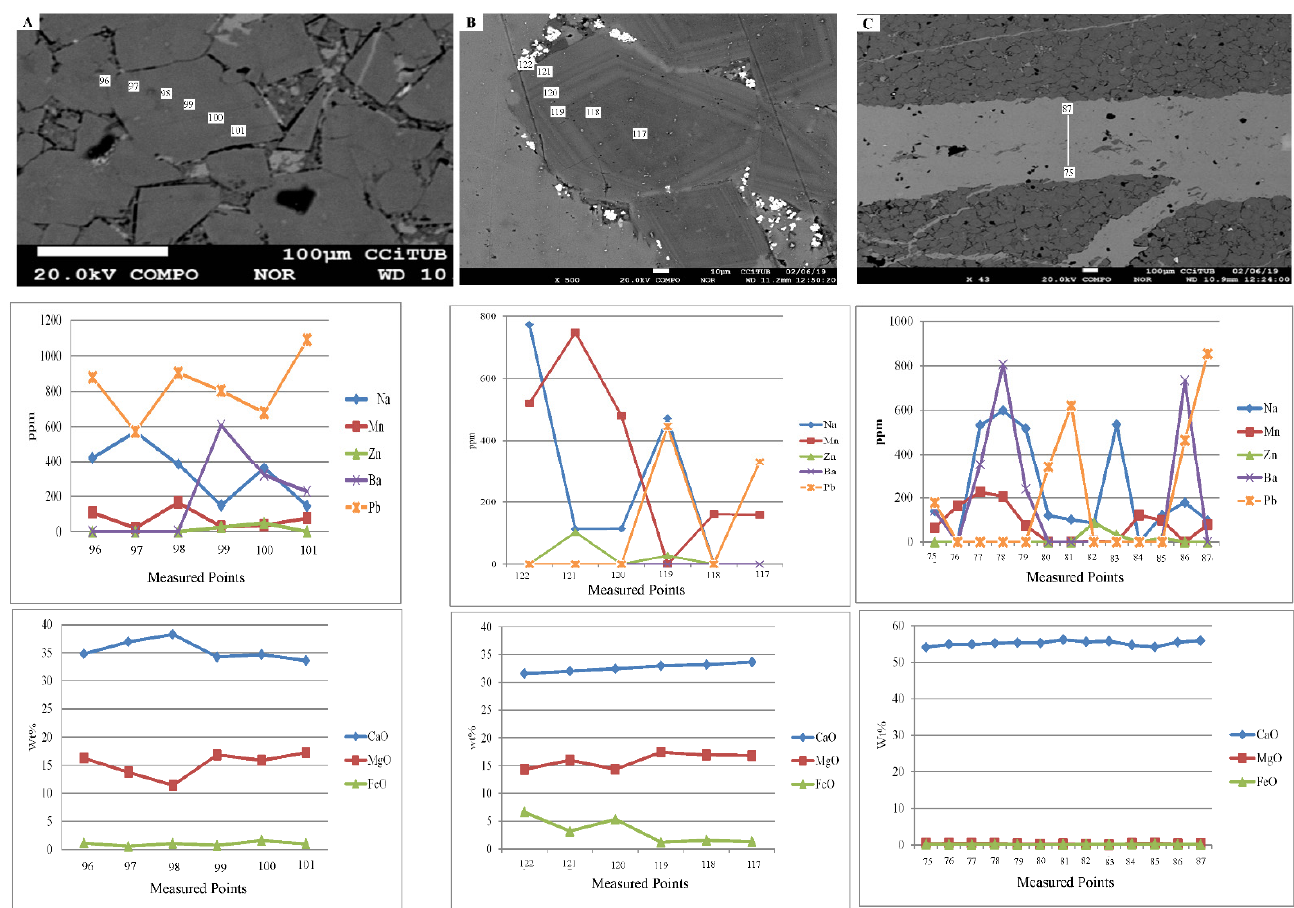
Figure 6. Microprobe profile analysis of the different types of dolomite and calcite phases. ( A ) Mi-